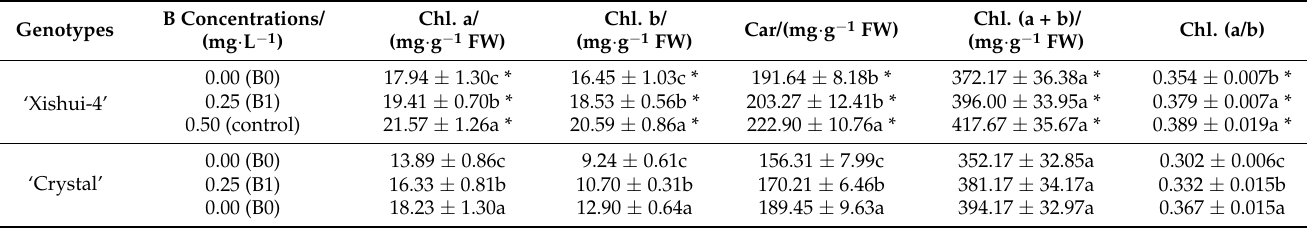
Table 3. Effects of B-deficiency on the leaf photosynthetic pigments of two grape genotypes.